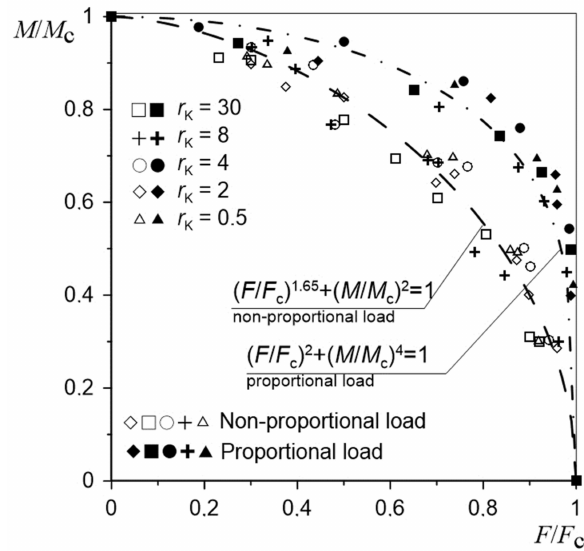
Figure 13. Tension force–torsion moment graph for specimens with notches for various load cases.